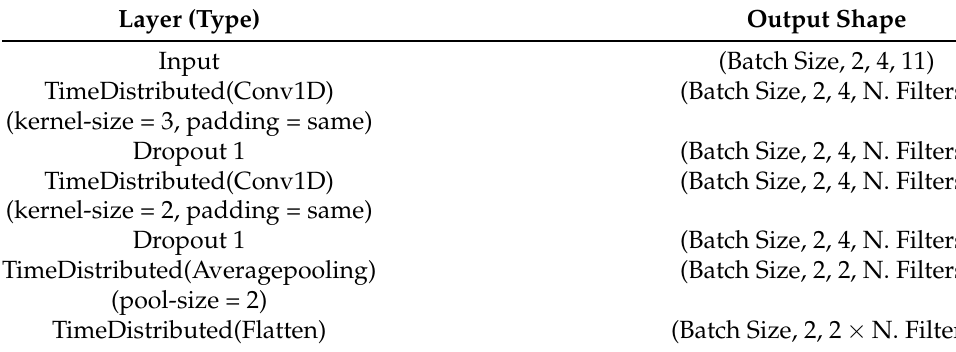
Table 7. CNN used to stake to the LSTM